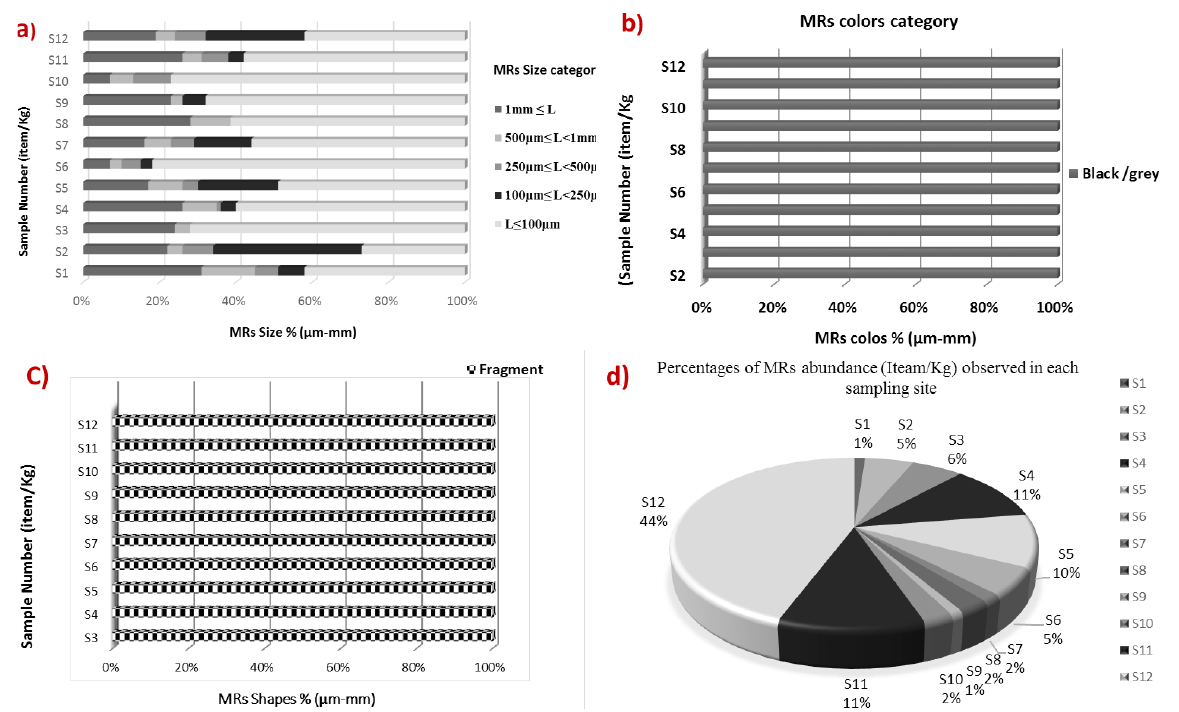
Figure 4. Percentages of A) Size; B) Shape; C) Color category; D) Abundance of MRs in each sampling site